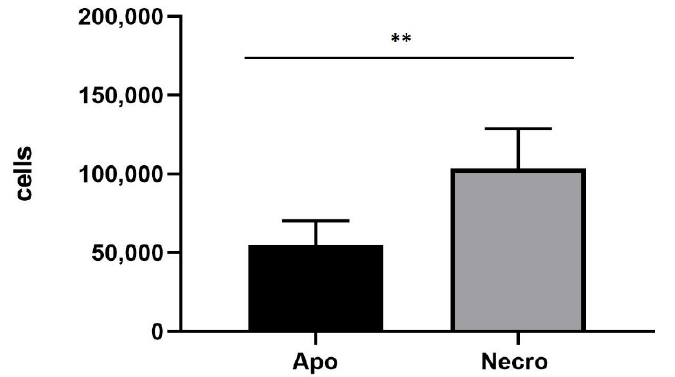
Figure 6. Annexin/PI on neural spheroids (3D SHSY5Y/RA) treated with 1.5 mM MPP + . The number of necrotic cells is higher, compared to apoptotic cells. The graph shows the means ± SEM of three experiments. Statistical analysis was performed through the analysis of variance (ANOVA) and the Dunnet’s post-test. The differences were statistically significant between apoptotic and necrotic cells. ** p < 0.01. causing cells necrosis [21–23].